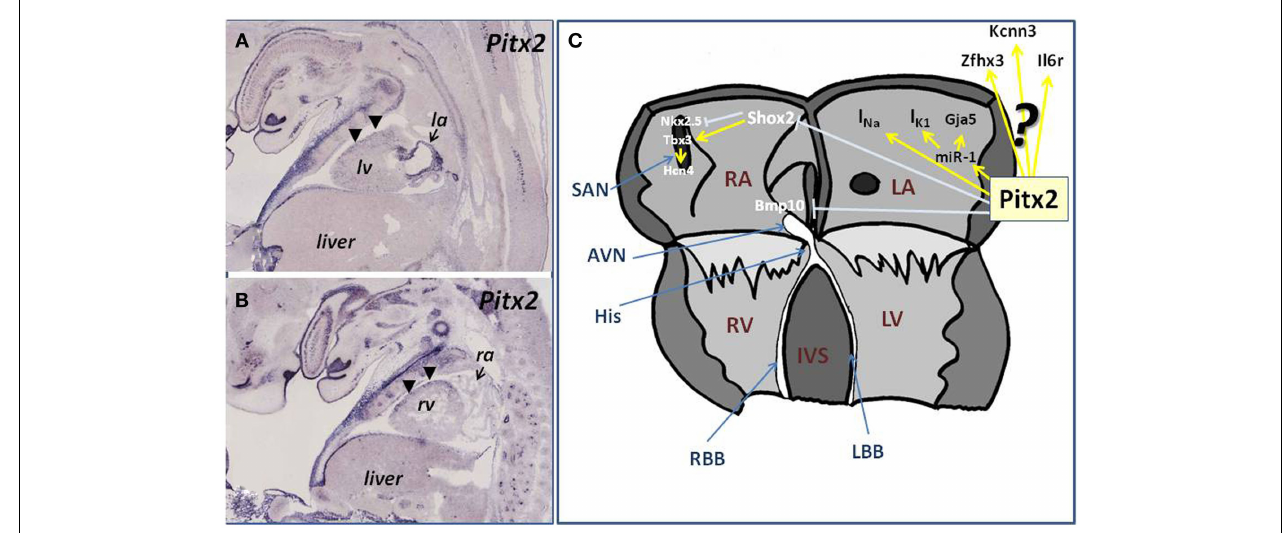
ventricular level [arrowheads, (A,B) ]. (C) Schematic representation of the current state-of-the-art role of Pitx2 in the developing and adult atrial chambers linked to atrial arrhythmogenesis. Pitx2 controls miR-1 expression in the left atrial chamber, providing thus a regulatory mechanism for I K1 and Gja1 function. In addition Pitx2 regulates I Na while inhibits the expression right atrial (Bmp10) and sinoatrial (Shox2) markers in the left atrium, which in turn play key regulatory roles on cardiomyocyte cell cycle and pacemaker activity, providing additional links to atrial